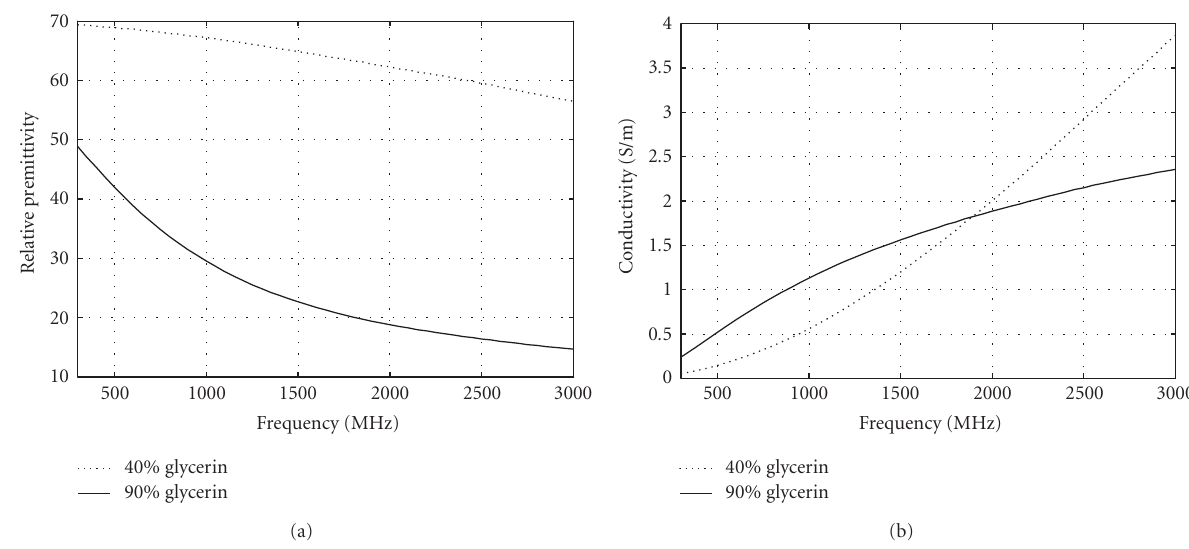
Figure 4: The measured (a) relative permittivity and (b) conductivity of the 90% and 40% glycerin: water baths used in these experiments.